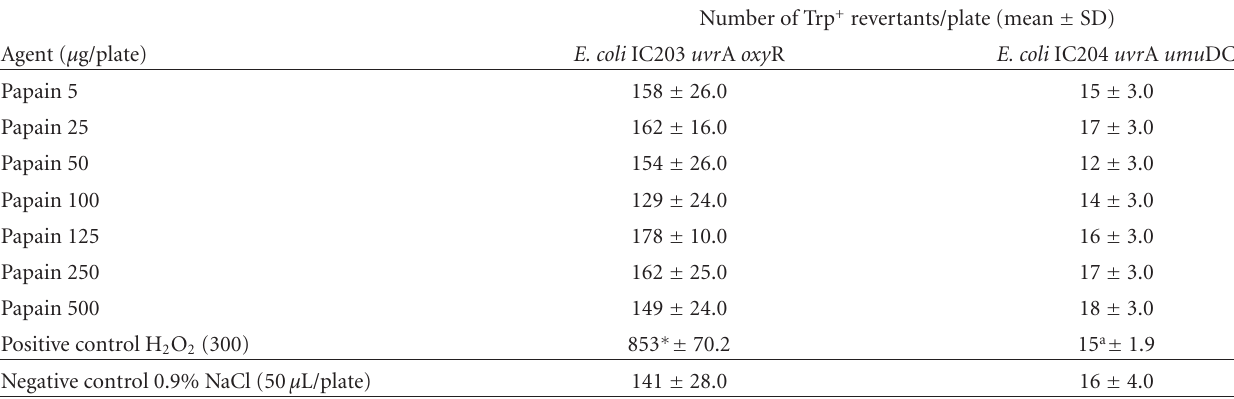
Table 3: Mutoxitest—Number of Trp + revertants/plate (mean ± SD). Aliquots (100 μ L) of exponentially growing cultures were mixed with 100 μ L of di ff erent concentrations of the papain or 0.9% NaCl, as negative control, and mixed with 2.5 mL molten top agar at 45 ◦ C and plated on minimal glucose agar plates supplemented with 0.5 mg tryptophan/litre. The mutagenic responses were expressed as the absolute number of Trp + revertants/plate, after incubation at 37 ◦ C, for 48 hours. Values are the mean of 3 independent experiments with standard deviations not exceeding